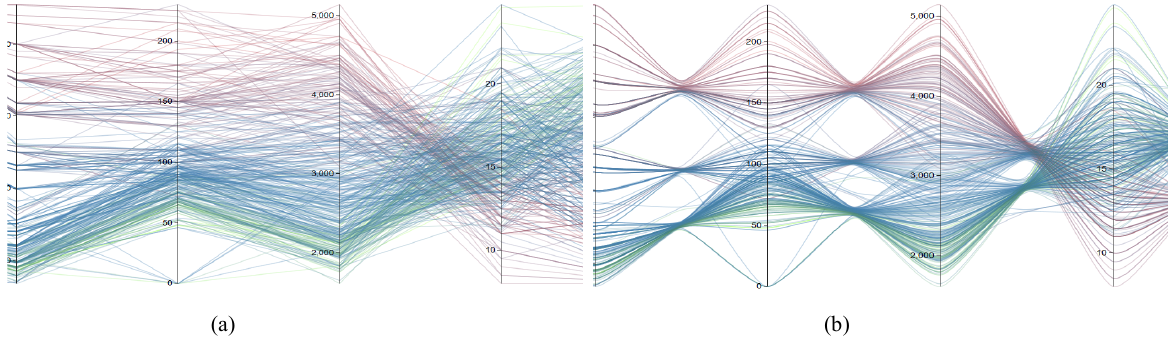
Figure 5. Parallel coordinates plot of clustered data shown in (a) and data representation with bundled curve separating distinct component shown in